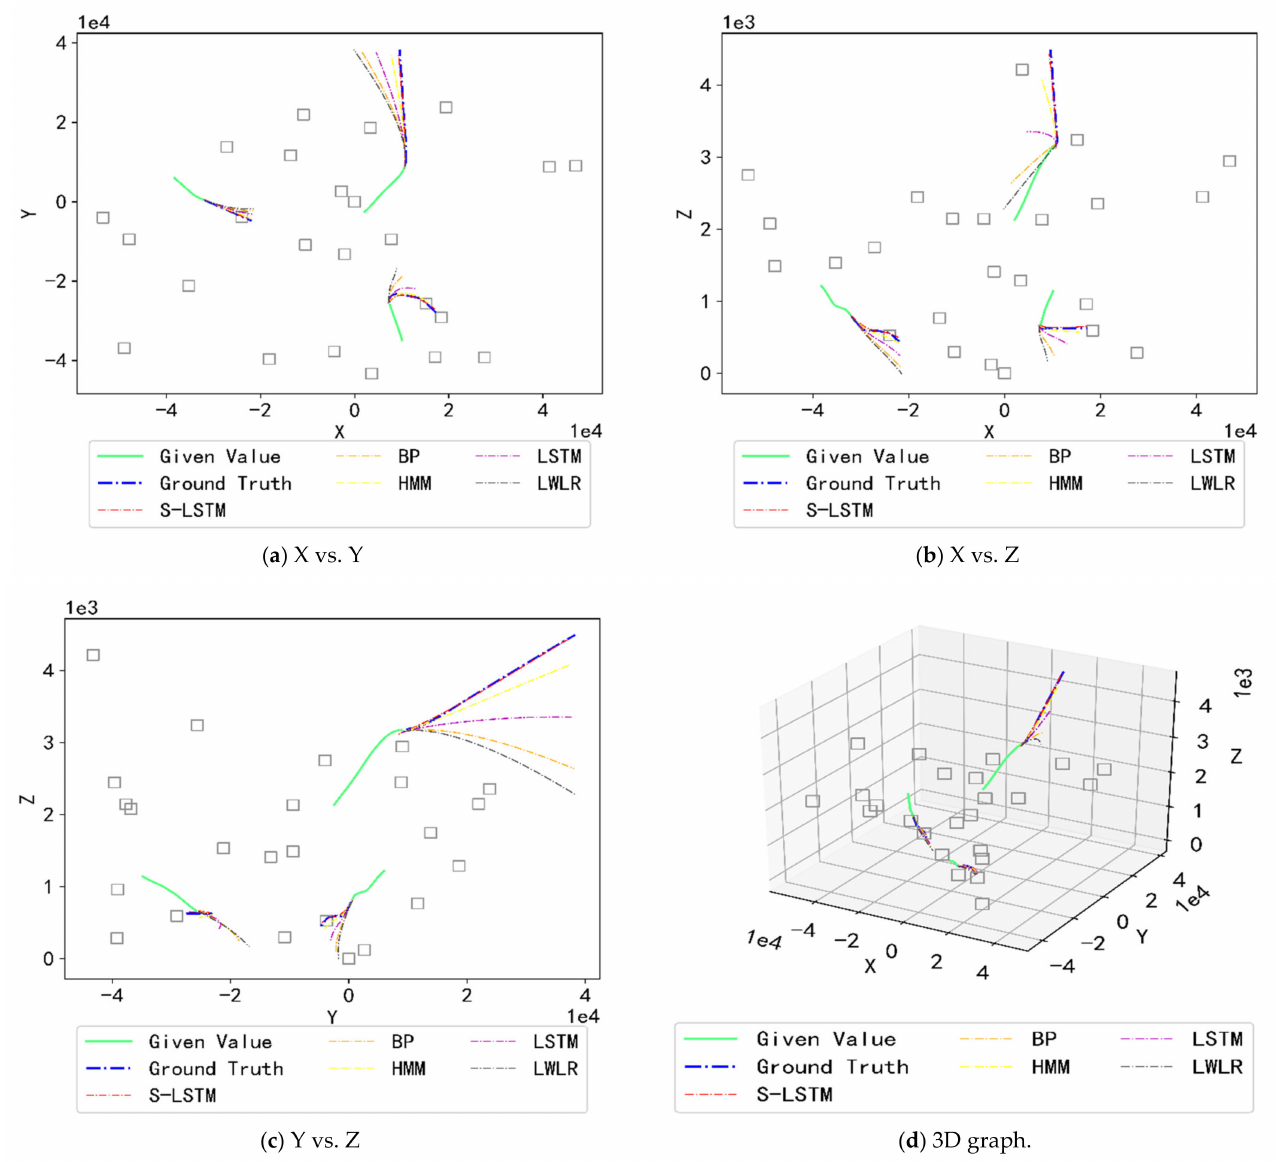
Figure 10. Visualization of prediction results for each prediction model.